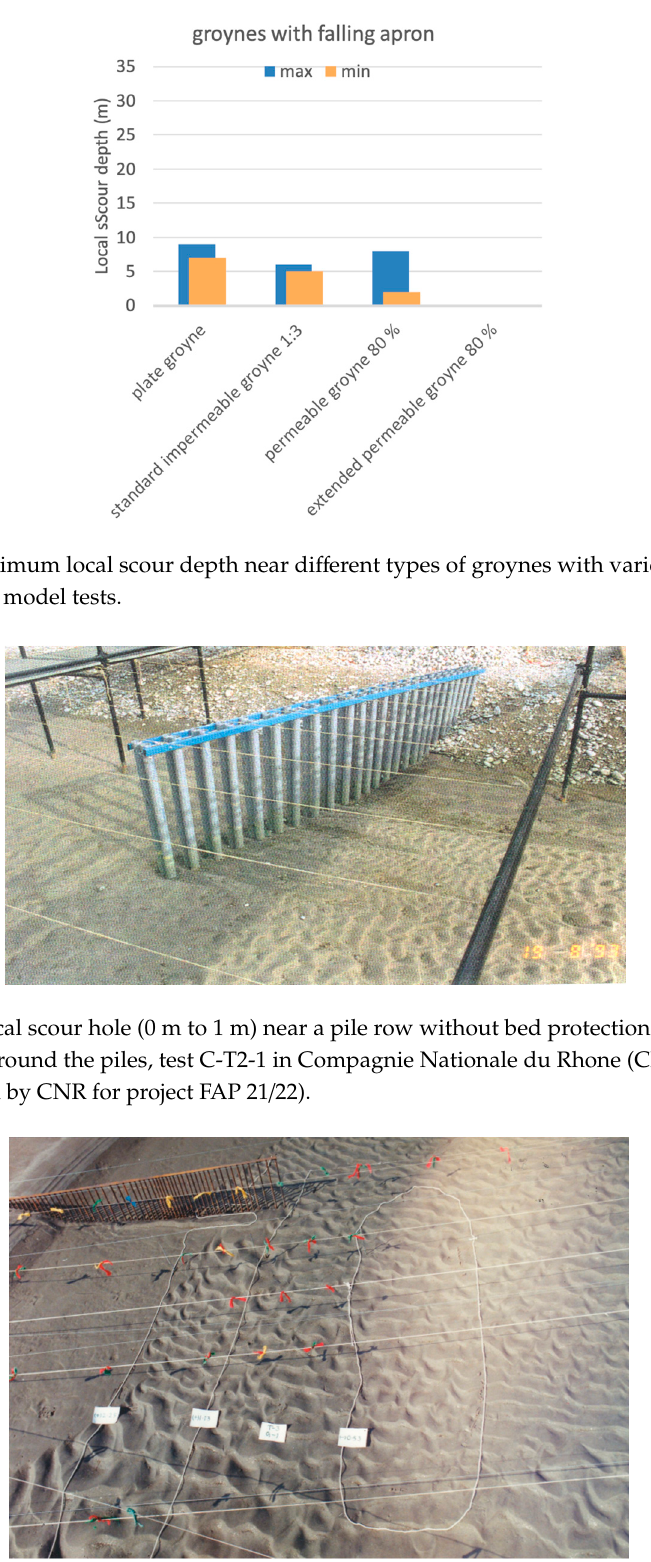
Figure 10. No local scour hole but only a shallow and wide interaction scour (about 3 to 4 m deep) due to the stopped bank erosion in the outer bend near repaired and extended pile row groynes without bed protection and without falling apron, test R-T3-2 at RRI, Bangladesh [39], (photograph taken by RRI for project FAP 21/22).